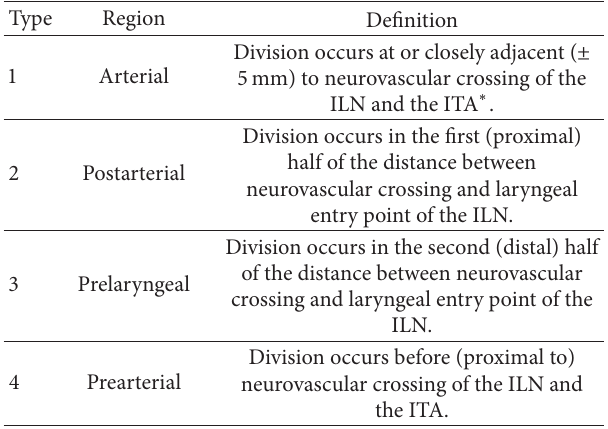
Table 1: Classification of anatomical location of terminal division point of the ILN ∗